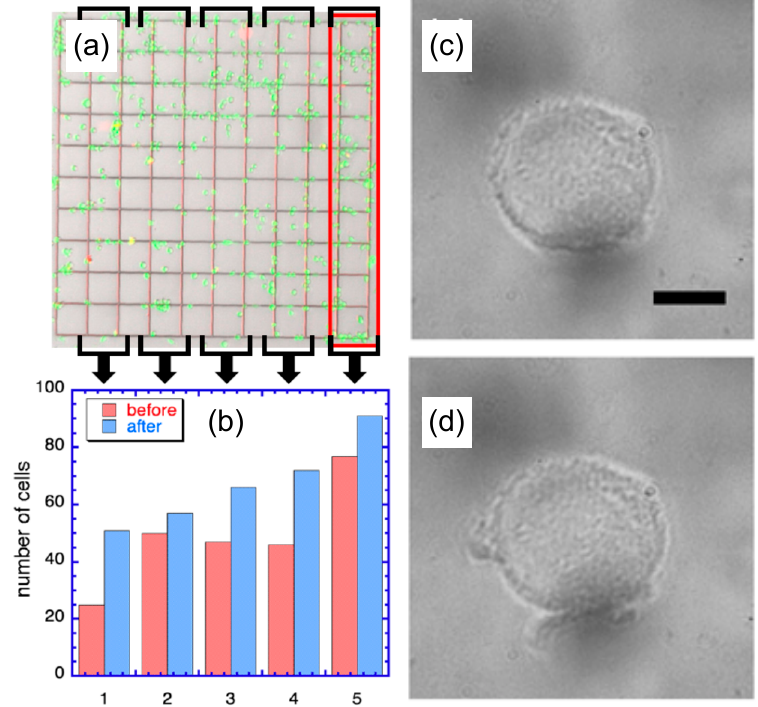
Figure 6. Effect of laser light on VM-M3 cells unfilled with mNPs. ( a ) Live/dead cell staining test: all cells luminesce green and none red, indicating all are alive and growing. Only cells within the red-outlined, bracketed box have been exposed to the laser. ( b ) Bar diagram of cell counts in boxes 1–5, with red = before and blue = 24 h after laser exposure of cells in box 5, all in growth medium. ( c ) An mNP-free, single VM-M3 cell before and ( d ) after laser exposure as described in the text. Scale bar 10 µm.